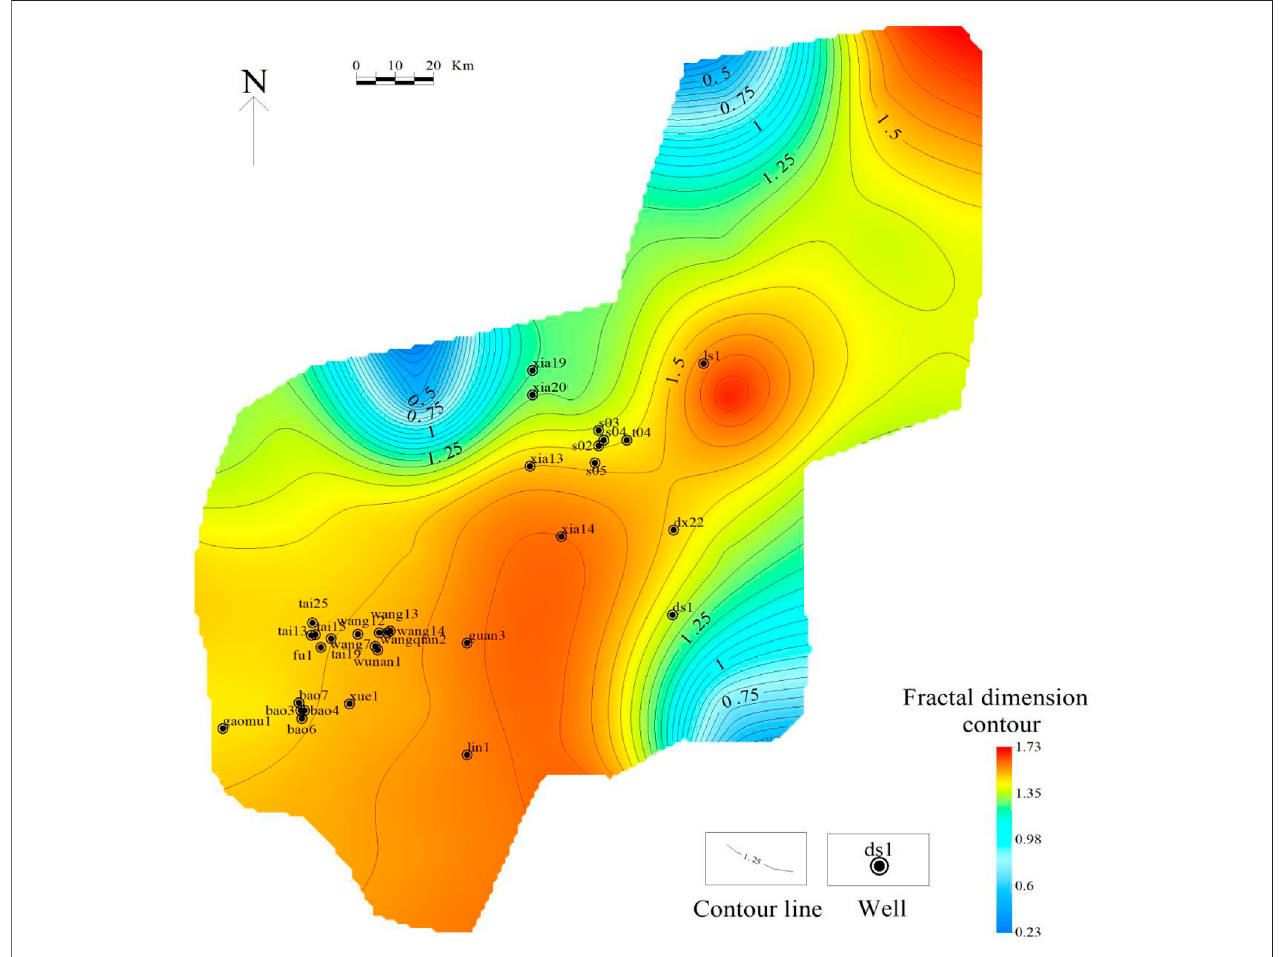
FIGURE 7 | Contour map of fractal dimensions of faults in Maokou Formation in southeast Sichuan (q = 2)